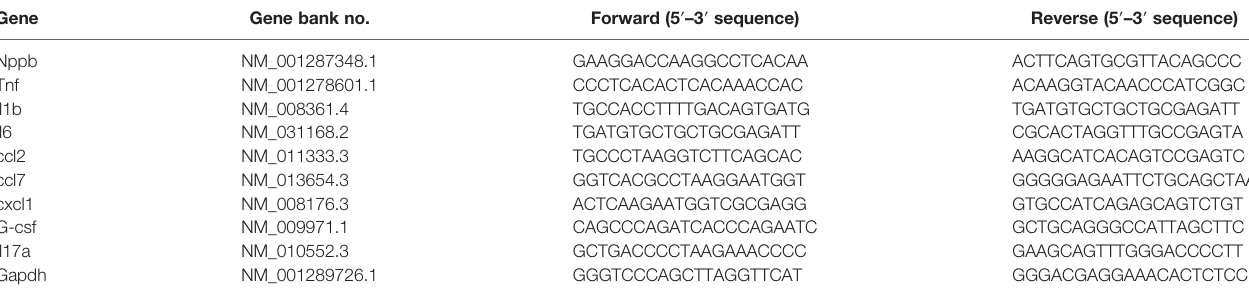
TABLE 1 | Primer sequences for quantitative PCR. Gene Gene bank no. Forward (5 ′ – 3 ′ sequence) Reverse (5 ′ – 3 ′